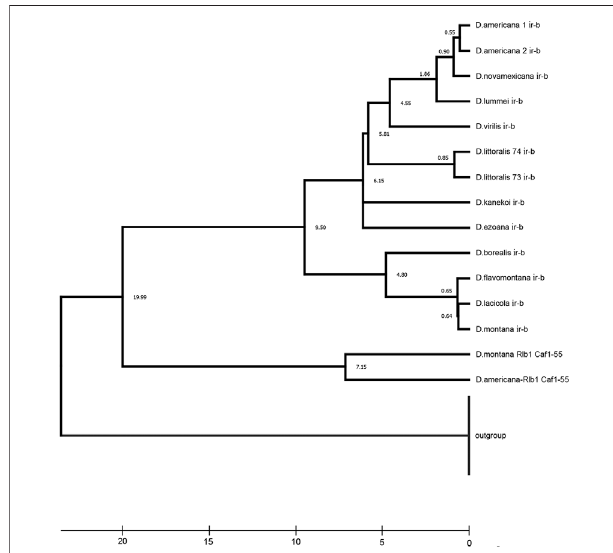
FIGURE 5 | Estimated time of the ancestral rearrangement occurrence, based on the time of mutation accumulation of homologous Ir-b repeats. The Timescale at the bottom of the fi gure is in millions of years. A timetree inferred by applying the RelTime method (Tamura et al., 2012). The timetree was computed using three calibration constraints. This analysis involved 28 nucleotide sequences. Evolutionary analyses were conducted in MEGA X (Kumar et al., 2018). Divergence times for all branching points in the topology were calculated using the Maximum Likelihood method and Tamura-Nei model (Tamura and Nei, 1993). The estimated log-likelihood value of the topology shown is − 4498.05. A discrete Gamma distribution was used to model evolutionary rate differences among sites [three categories (+G, parameter (cid:1) 3.0235)]. The tree is drawn to scale, with branch lengths measured in the relative number of substitutions per site. This analysis involved28nucleotidesequencesoftheinvertedrepeats.Therewereatotalof 700 positions in the fi nal